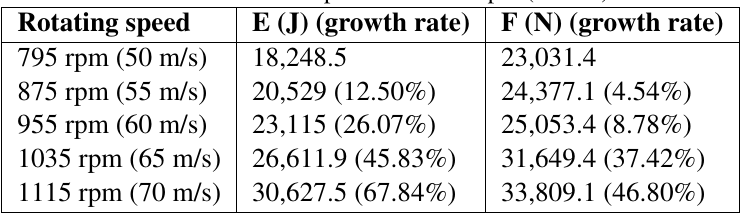
Table 5 Data compared with 795 rpm (50 m/s)